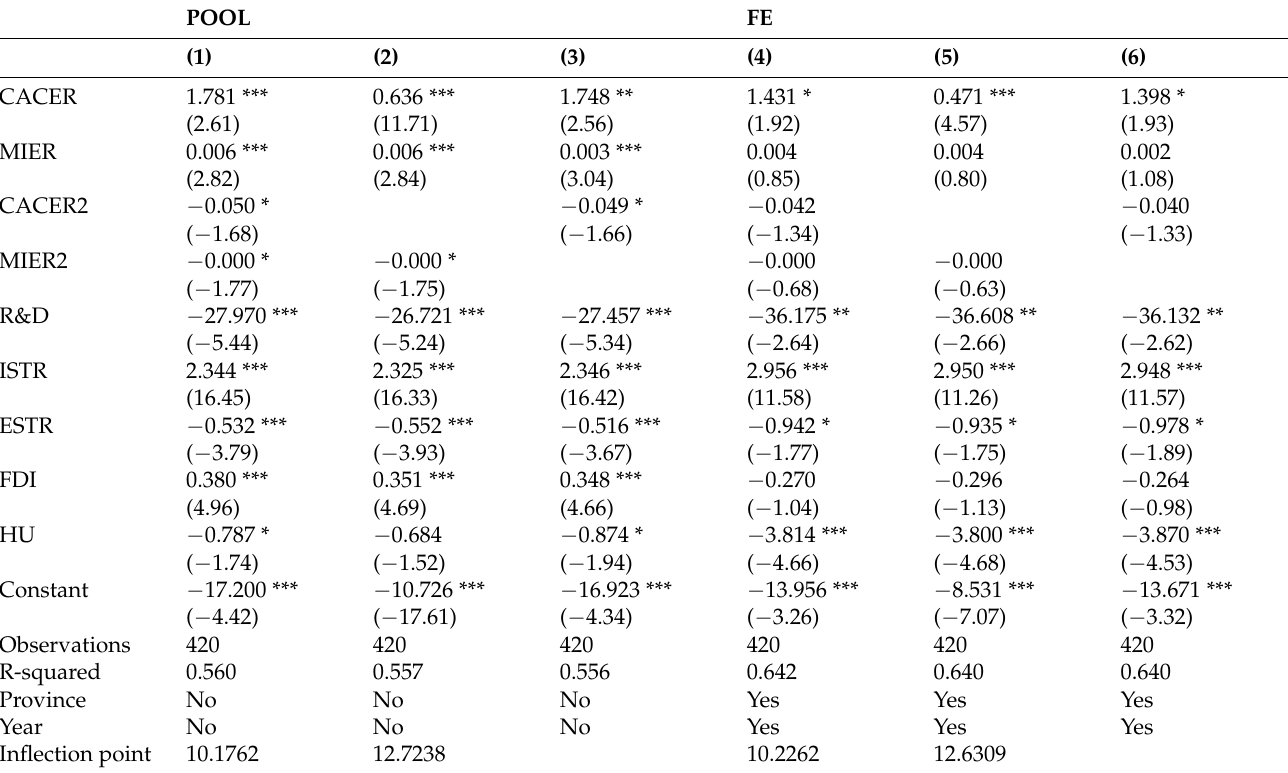
Table 7. Estimated results of the impact of ERs on